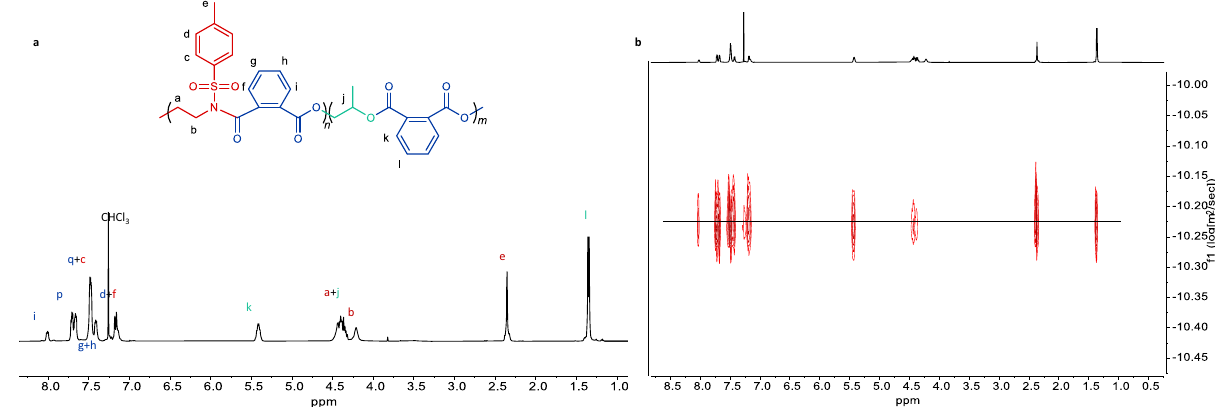
Fig. 4 Nuclear magnetic resonance characterization. a 1 H NMR of poly(TAz- alt -PA)- b -poly(PA- alt -PO). b DOSY NMR spectra of poly(TAz- alt -PA)- b - poly(PA- alt